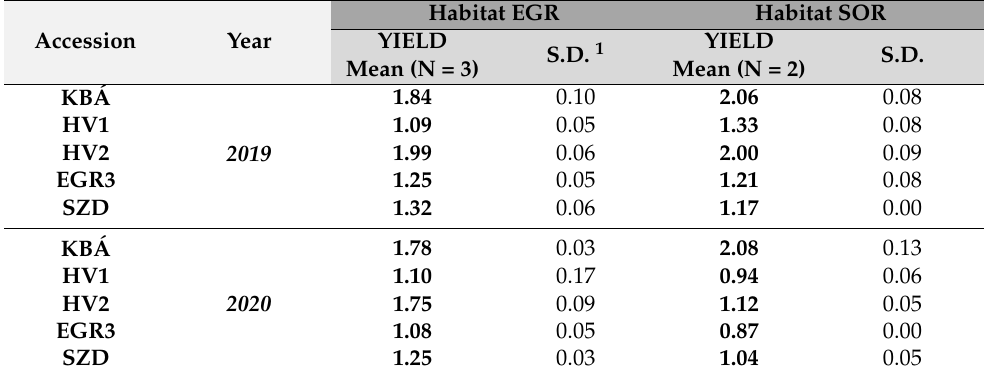
Table 1. Essential oil yield (mL/100 g dry plant material) of the horsemint accessions in full